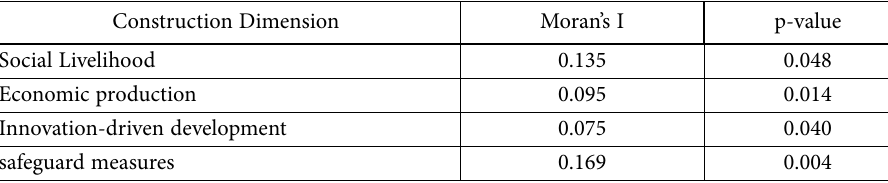
Table 3. Global Moran’s I in different dimensions Construction